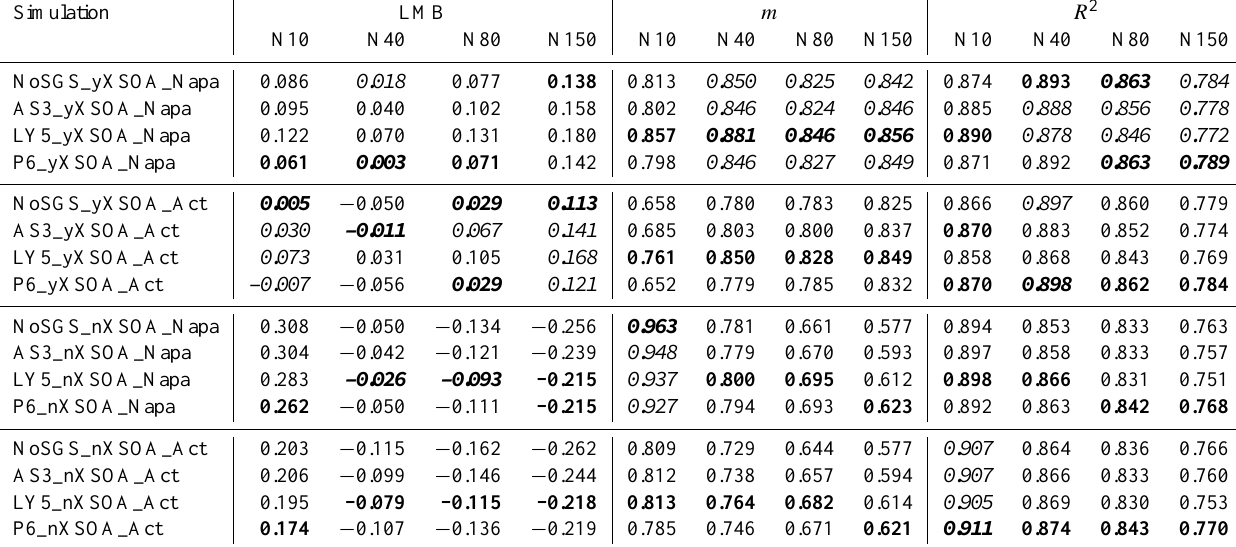
Table 4. Log-mean bias (LMB), slope of the log-linear regression ( m ), and coefficient of determination ( R 2 ) between the simulated annually averaged N10, N40, N80, and N150 and those measured at 21 surface sites. For each group of simulations with the same SOA amount and grid-resolved nucleation scheme, the best statistical result in each column is bolded. For each group of simulations with the same sub-grid sulphate scheme, the best statistical result in each column is